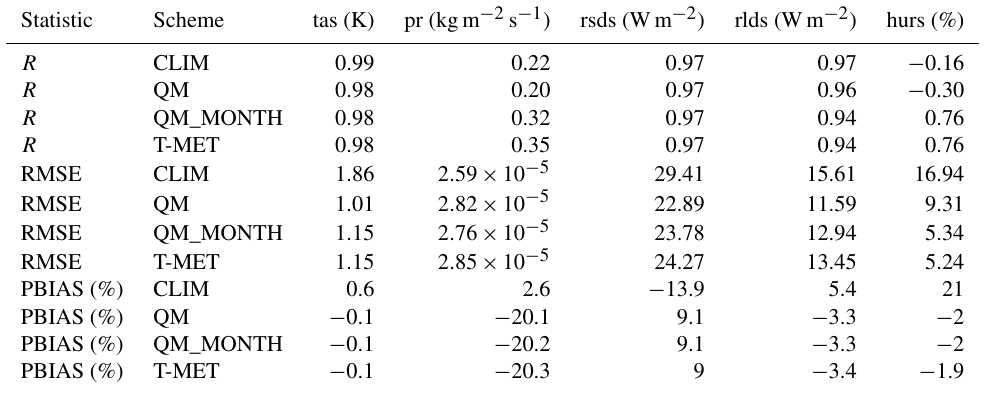
Table 4. Statistics from the evaluation shown in Fig. 4. Correlation ( R ), root mean squared error (RMSE), and percentage bias (PBIAS) are given relative to station measurements at Weissfluhjoch